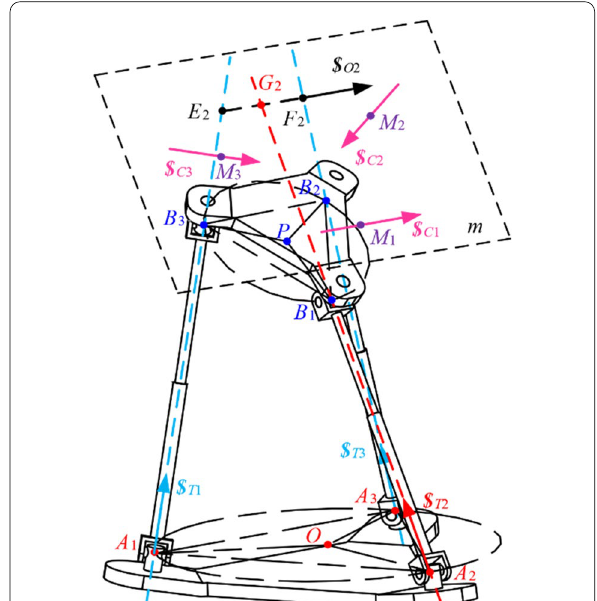
Figure 6 Transmission singularity